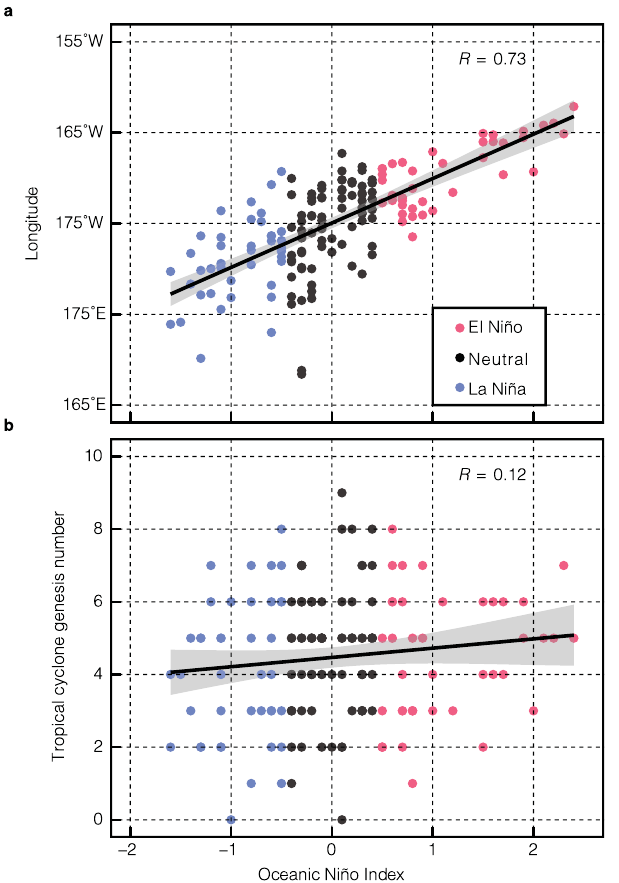
Fig. 1 | Thewestern Paci fi c warm poolexpands during ElNiño, butthe tropical cyclone (TC) genesis number remains unchanged. a The western Paci fi c warm poolcentroidlongitudesinElNiño,neutral,andLaNiñaphasesaredenotedbyred, black,and blue fi lled circles, respectively. b same as a but for TCgenesisnumbers. El Niño and La Niña are denoted with the Oceanic Niño Index (see Methods). The westernPaci fi c warm pool is de fi ned asthe regionwhere seasurfacetemperatures arewarmerthan28°C.TheTCgenesisnumberisobtainedfromtheJointTyphoon WarningCenter.The95%con fi